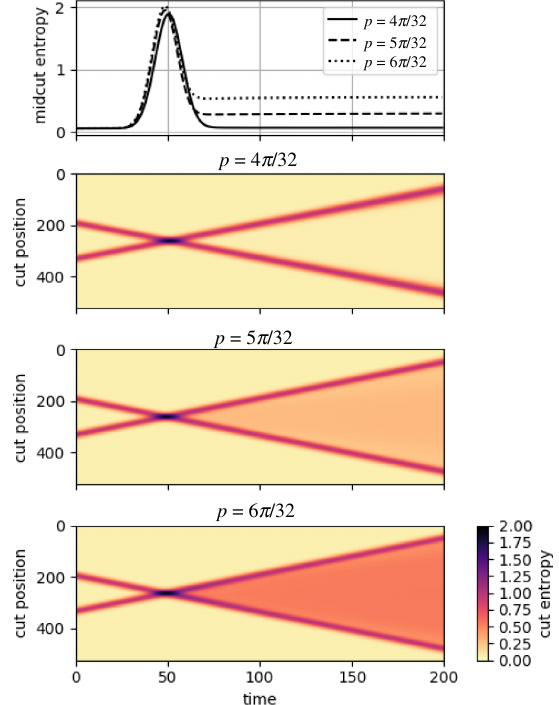
FIG. 27. Cut entropy for kink-antikink collisions, in the absence of a longitudinal field, with initial kink momentum p and antikink momentum − p , for three different values of p . The Hamiltonian parameters are g = 0.9, λ = 0.3, h = 0, and the wavepacket width is σ = 19.0. The vacuum bond dimen- sion is D = 14, with a limit D ≤ 64 imposed during